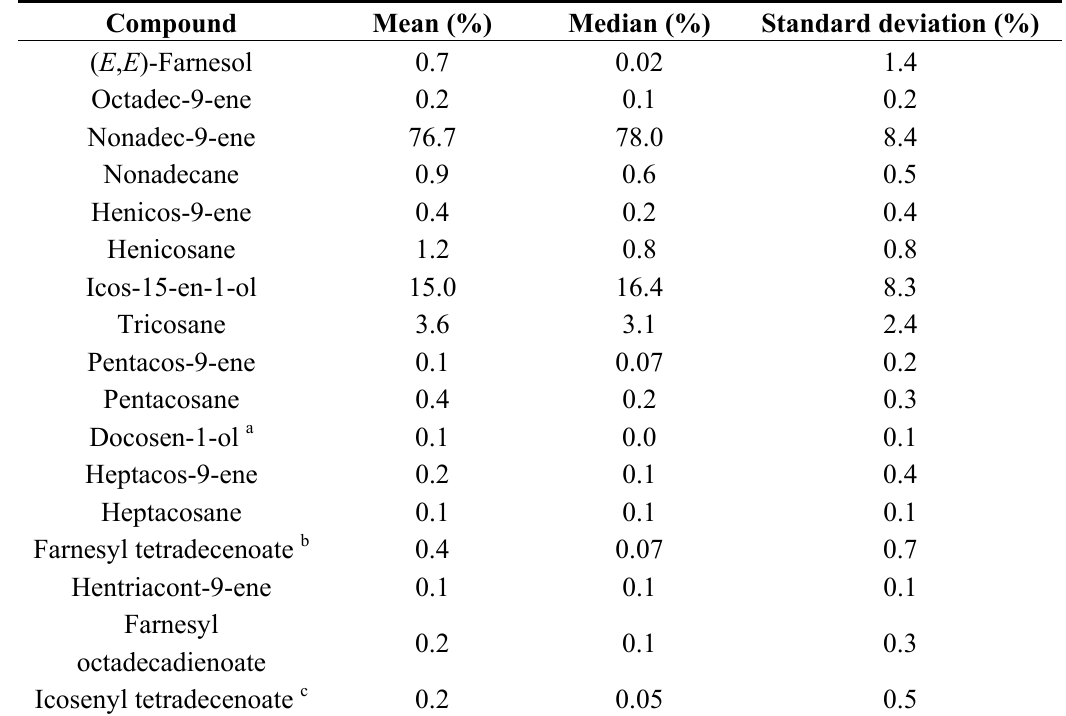
Table 1. Composition (relative percent) of the labial gland secretion of B. ruderatus males (N = 14). Components < 0.1% are not